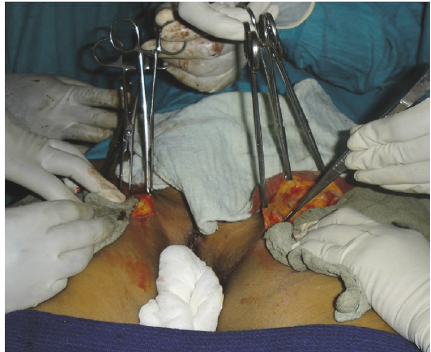
Figure 6: Follow-up